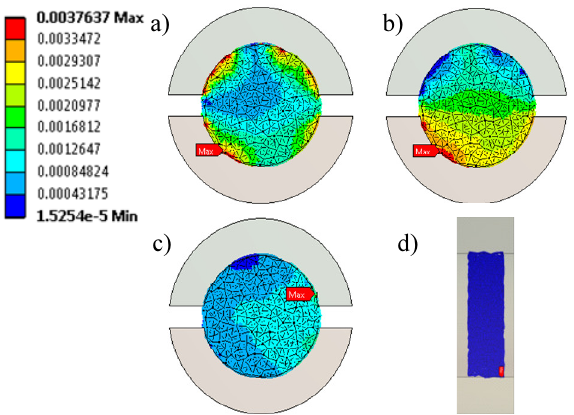
Fig. 11. Displacements (m) of the Marshall DE model: a), b), c) and d) are total, vertical, horizontal and longitudinal, respective- ly